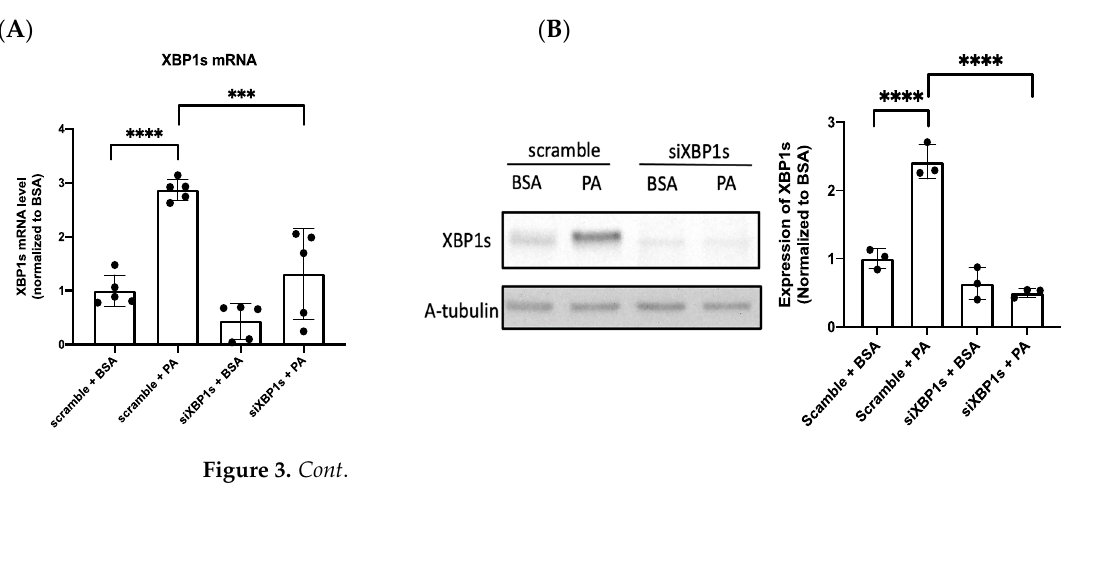
Figure 3. The IRE1 α –XBP1 axis protects endothelial dysfunction in PA-exposed cells . The silencing of XBP1s by siRNA was analyzed using ( A ) qRT-PCR and ( B ) Western blotting. ( C ) The wound healing assay was observed at 0 h and 24 h post-scratching after silencing XBP1s under PA treatment (scale bar: 100 μ m). ( D ) Protein expression of eNOS, p-eNOS after the silencing of XBP1s. Data are presented as the mean ± SEM, and the images are representative of three independent groups. Data c on t r o l sc r a m b l e + B S A sc r a m b l e + P A s i X B P 1s s i X B P 1s + B S A s i X B P 1s + P A 0.0 0.51.01.52.0 p - e N O S ex p r ess i on l eve l ( N o r m a li z e d t o c on t r o l )